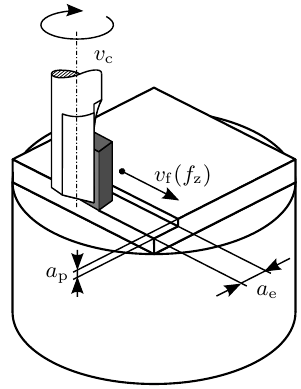
Figure 7. Kinematics in side milling using single-edged